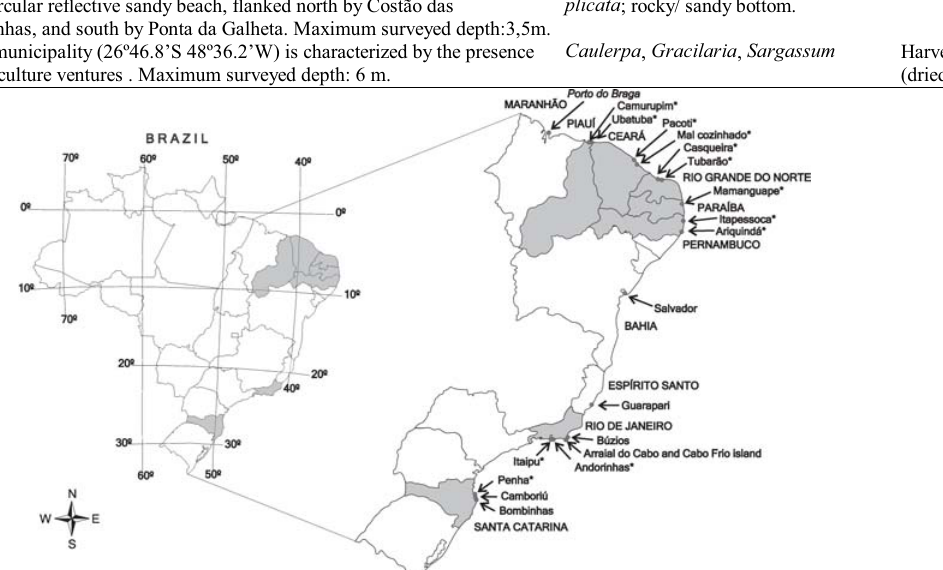
Fig. 1. Areas surveyed along the Brazilian coast. Localities marked with asterisk are those included in data analyses.